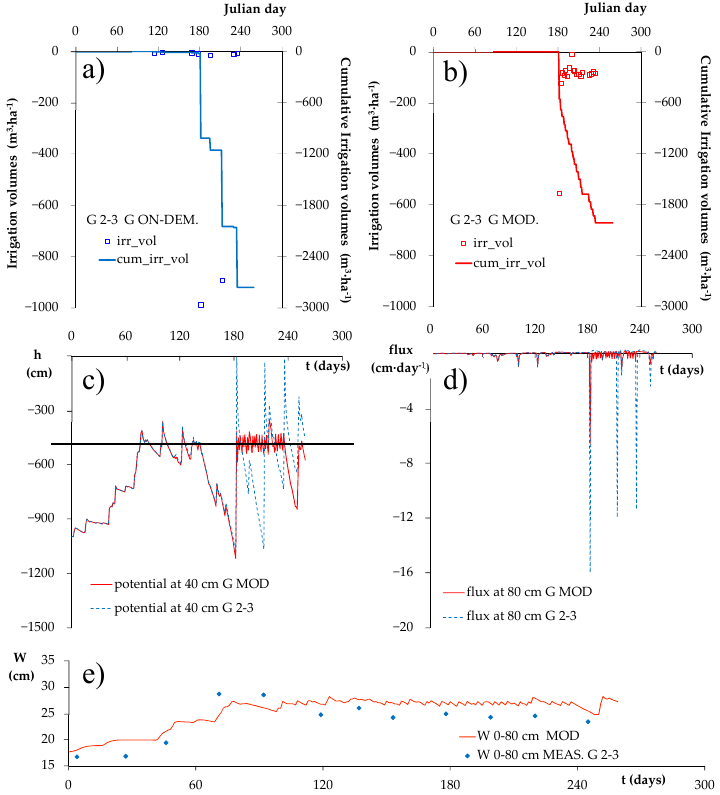
Figure 7. FARM G 2-3. ( a ) Irrigation volumes (both per single day and cumulative) calculated by the model (MOD); ( b ) irrigation volumes actually supplied by the farmer (ON-DEM); ( c ) pressure head at 40 cm depth; ( d ) percolation fluxes at 80 cm; ( e ) comparison between the time evolution of the water storage predicted by the model (MOD) and that estimated starting from the electromagnetic induction technique (EMI) sensor apparent electrical conductivity (ECa) readings